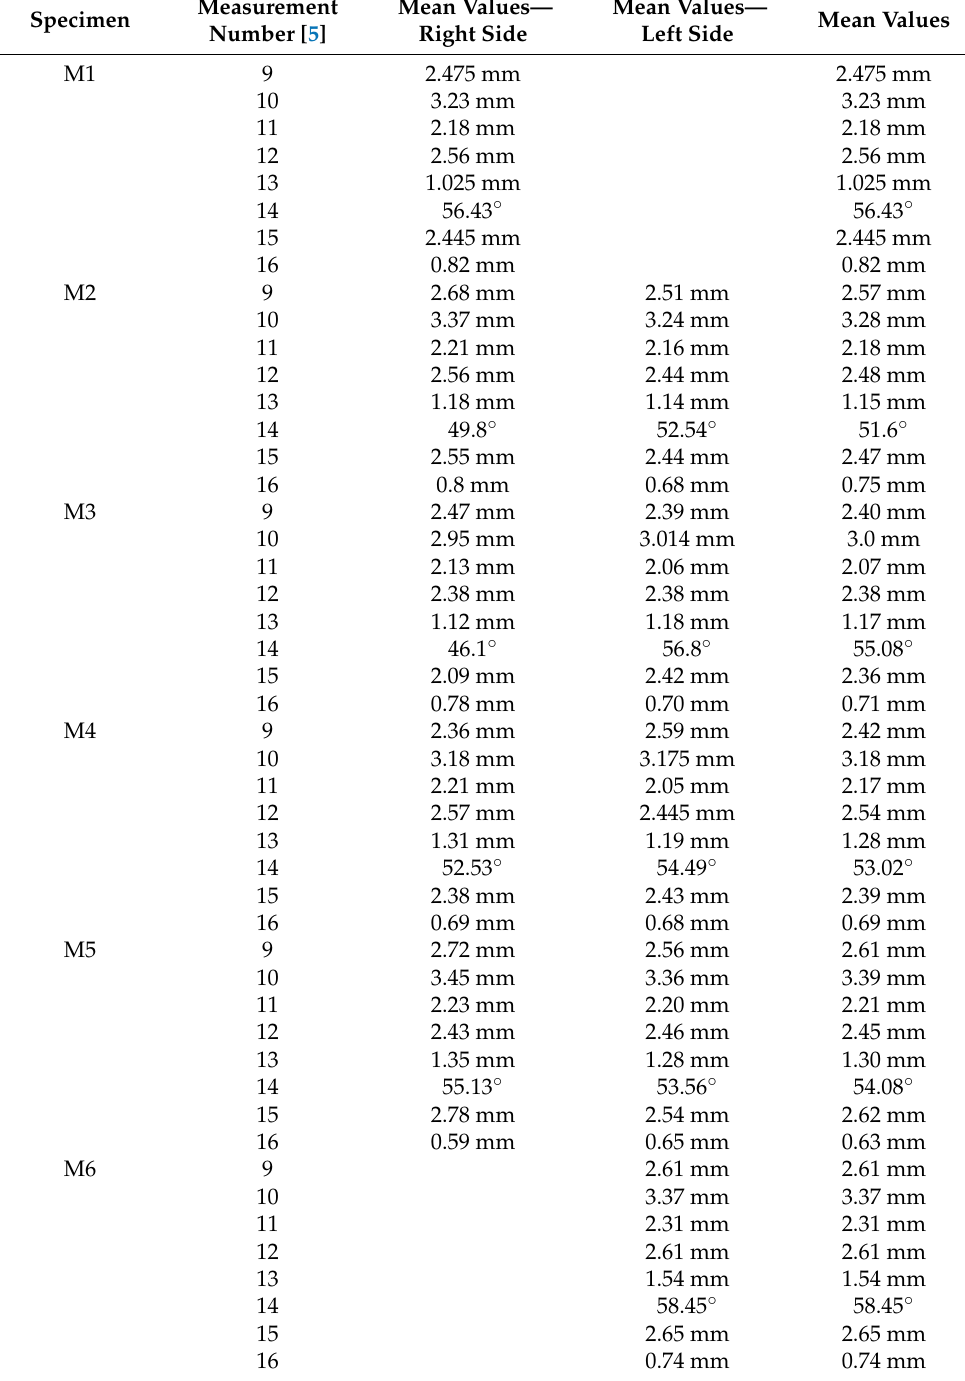
Table 4. Metric dimensions of the incudes in green monkey